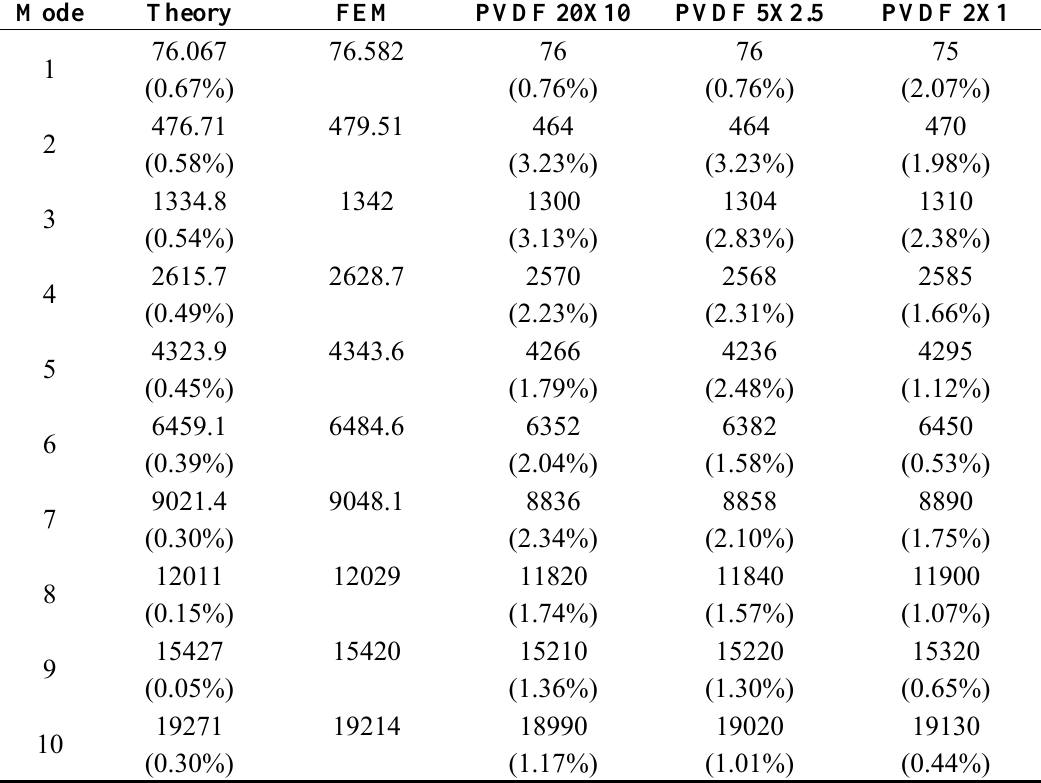
Table 1. Resonant frequencies of the bending modes identified by PVDF (impact location A 1